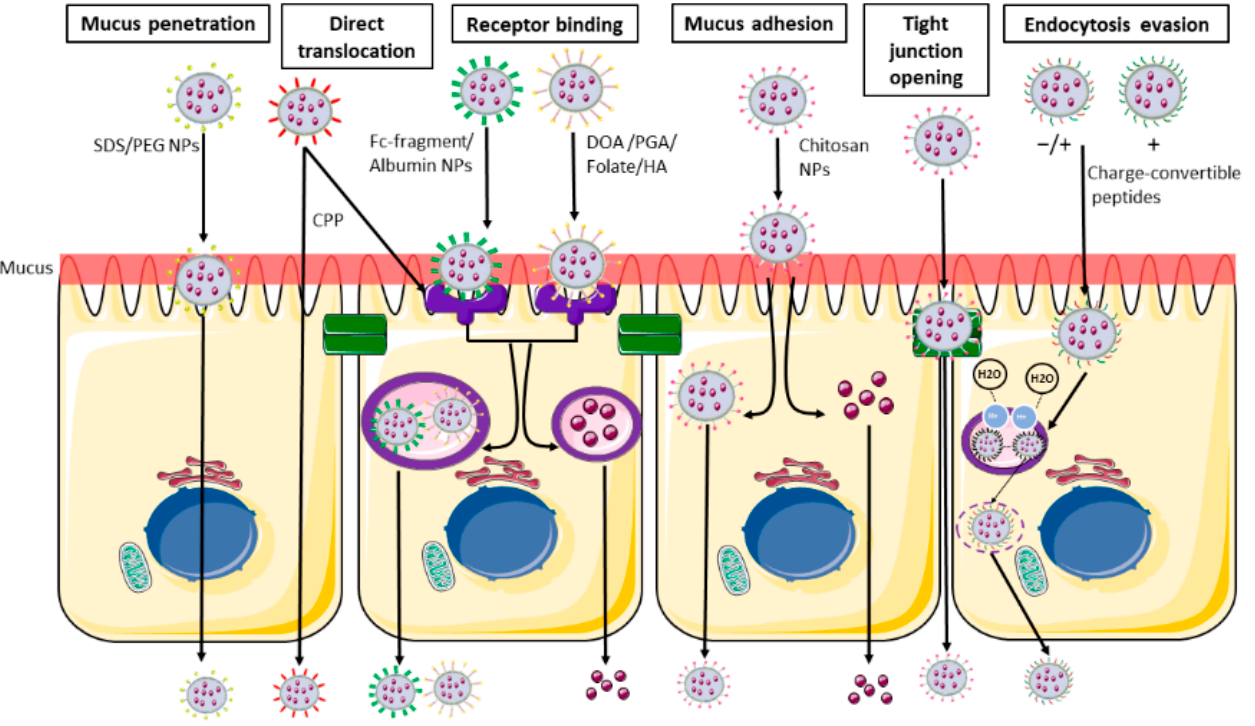
Figure 3. Main nanoparticles functionalization and their intestinal transport. From the left: Schematic representation of mucus penetrating NPs (SDS/PEG), able to penetrate the mucus layer and directly pass through the blood flow. Receptor binding NPs (DOA/PGA/folate/HA/albumin/Fc-fragment) able to bind the cell surface using the ligand-receptor binding and are then internalized in endocytic vesicles and released in the systemic circulation. CPP (cell penetrating peptides) are able to undergo both receptor binding internalization and direct translocation. Muco-adhesive NPs and tight junction opening NPs (chitosan) are able to be retained in the mucus layer, and then undergo transcellular passage or pass through the opened tight junction. Charge-convertible peptides are able to evade the lysosomal degradation using the proton sponge mechanism. SDS: sodium dodecyl sulphate; PEG: polyethylene glycol; CS: chondroitin sulphate; DOA: deoxycholic acid; PGA: poly-glutamic acid; HA: hyaluronic acid. The image was created with the use of Servier Medical Art modified templates, licensed under a Creative Common Attribution 3.0 Unported License (https://smart.servier.com, accessed on 19 February 2022).